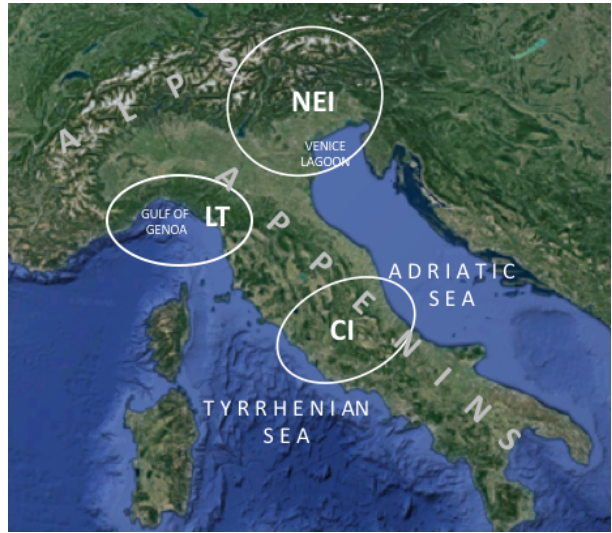
Figure 1. Italian target areas and geographic places mentioned in the text (figure background from Imagery © 2021 Land- sat/Copernicus, data SIO, NOAA, U.S. Navy, NGA, GEBCO, and Imagery © 2021 TerraMetrics, and map data © 2021 GeoBasis- DE/BKG, © Google 2009, and Inst. Geogr.